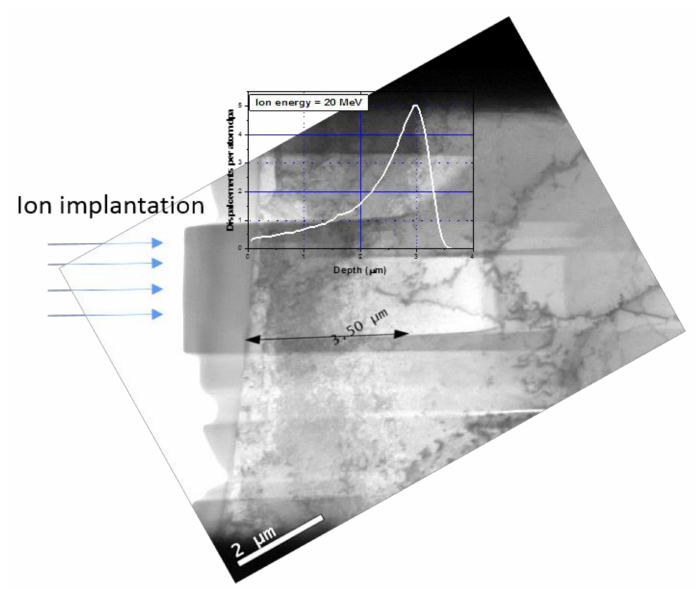
Figure 9. TEM micrograph of the lamella extracted from the sample of EFDA pure Fe irradiated at 300 ◦ C and high dose, showing the irradiated peak wholly contained in the